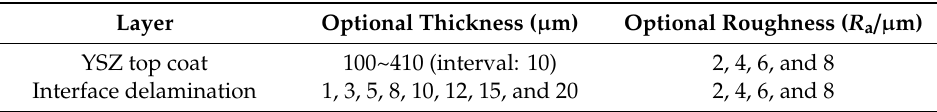
Table 2. Parameter settings for the thickness and